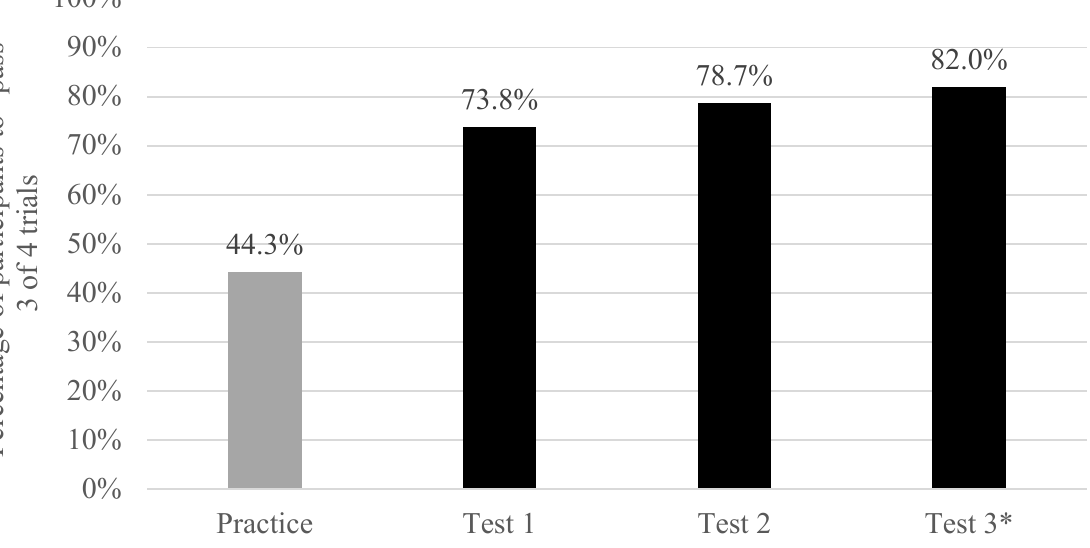
Figure 11. Percentage of participants to pass with the trials regrouped into sets of four with a practice, test 1, test 2 and test 3. * Test 3 only consisted of three trials because participants in the current study completed 15 trials.